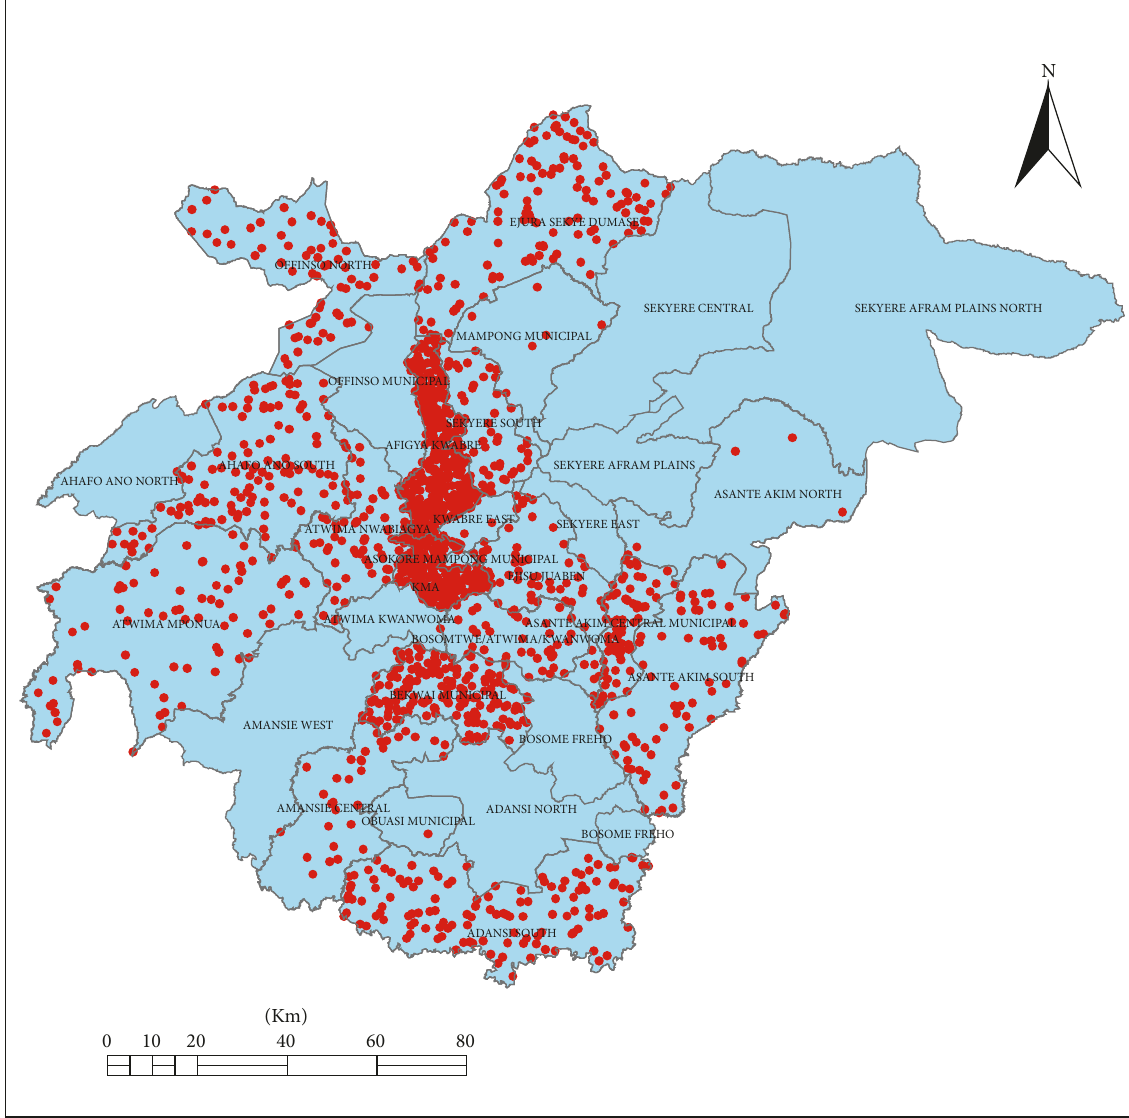
Figure 1: Case density of the hypertension admissions by clients place of residents, Ashanti Region,